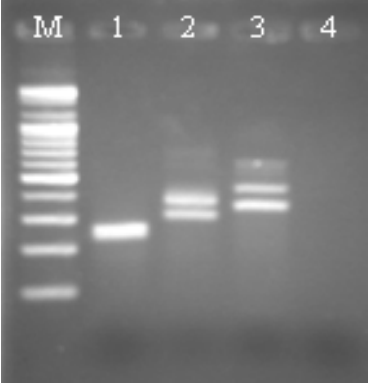
Figure 5. The corresponding gel electrophoresis of the PCR analytes for the selectivity tests. Channels M: the ladder DNA marker; 1: Arabidopsis thaliana (252 b); 2: H5 AIV (358 b) 3: PSMA5 (432 b); and 4: negative control. Double bands on each channel indicated the presence of both single and double stranded DNA analytes in the PCR products. Arabidopsis thaliana ’s on Channel 1 obviously was too short in size to display discrete bands on this